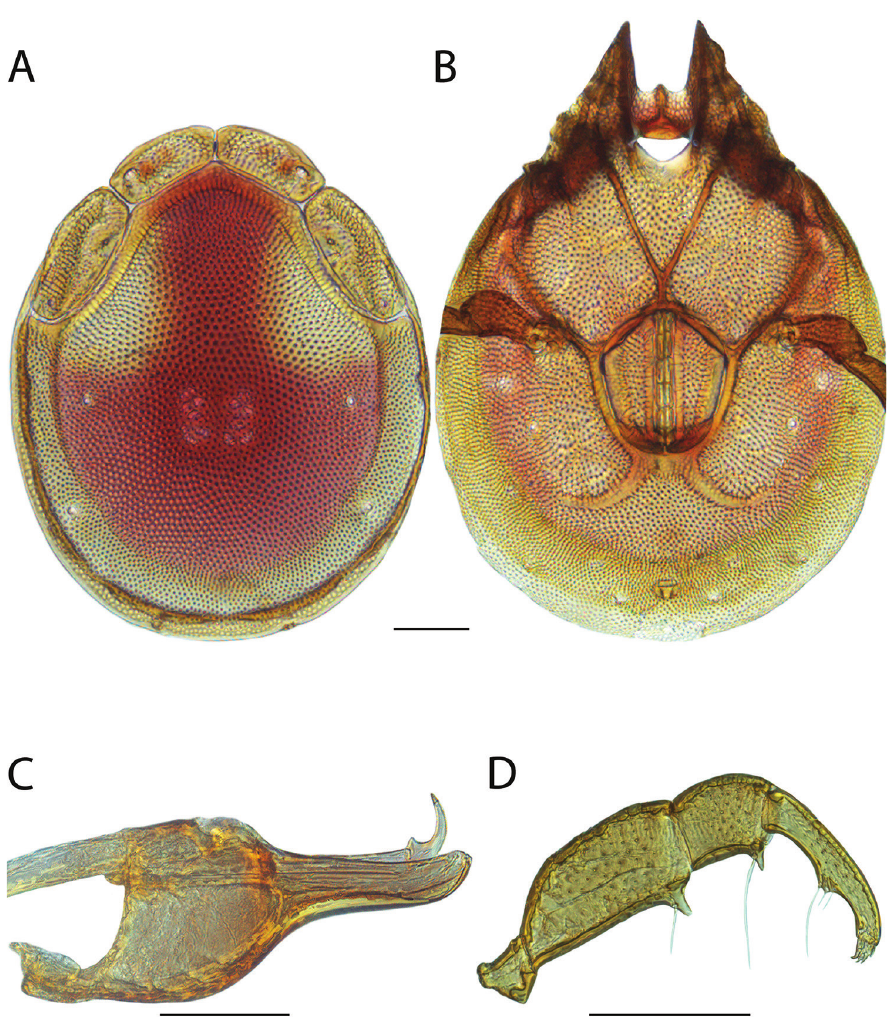
Figure 48. Torrenticola danielleae sp. n. female: A dorsal plates B venter (legs removed) C subcapitulum D pedipalp (setae not accurately depicted). Scale = 100